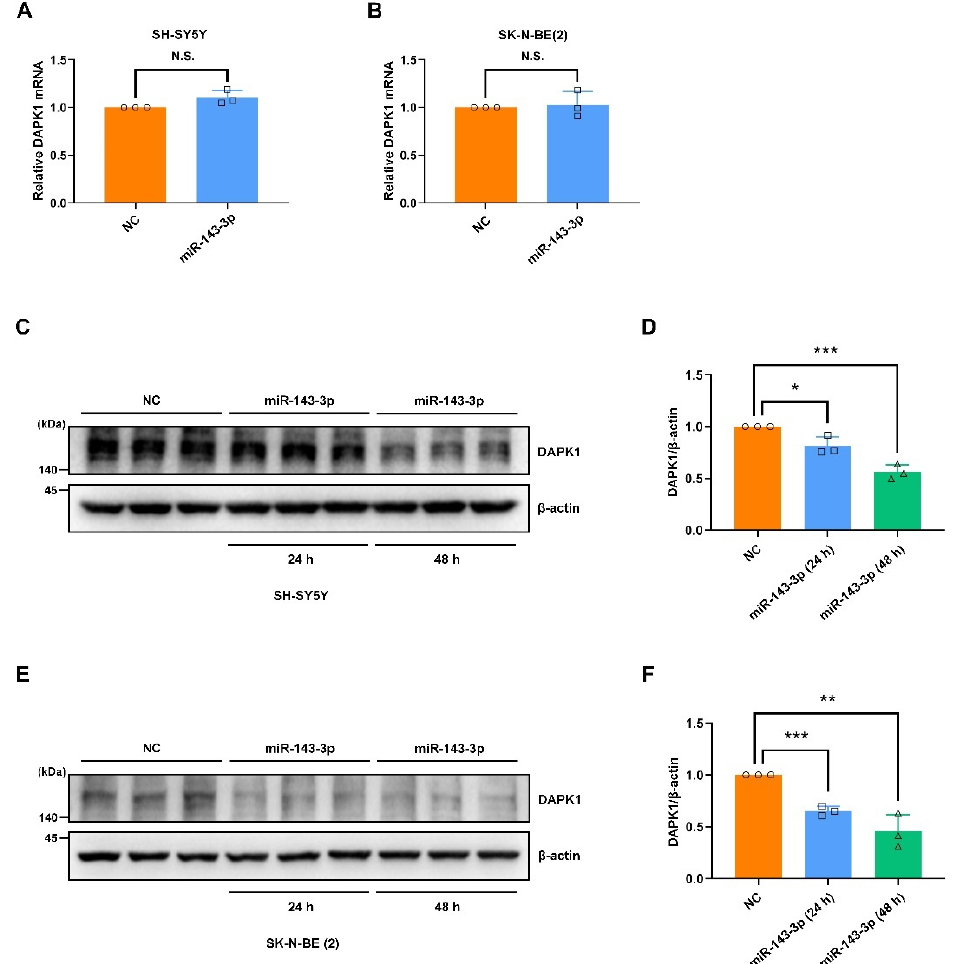
Figure 2. The DAPK1 protein levels are significantly decreased by miR-143-3p. ( A , B ) SH-SY5Y ( A ) and SK-N-BE(2) ( B ) cells were treated with miR-143-3p or NC for 24 h, and DAPK1 mRNA expression was analyzed by quantitative RT-PCR. ( C – F ) SH-SY5Y ( C , D ) and SK-N-BE(2) ( E , F ) cells were transfected with NC for 48 h, miR-143-3p for 24 h, or miR-143-3p for 48 h, and DAPK1 protein expression was analyzed by immunoblotting. Each data point (circles, squares and triangles) represents the mean ± SD of three independent experiments (* p < 0.05, ** p < 0.01, *** p < 0.001, N.S., not significant).